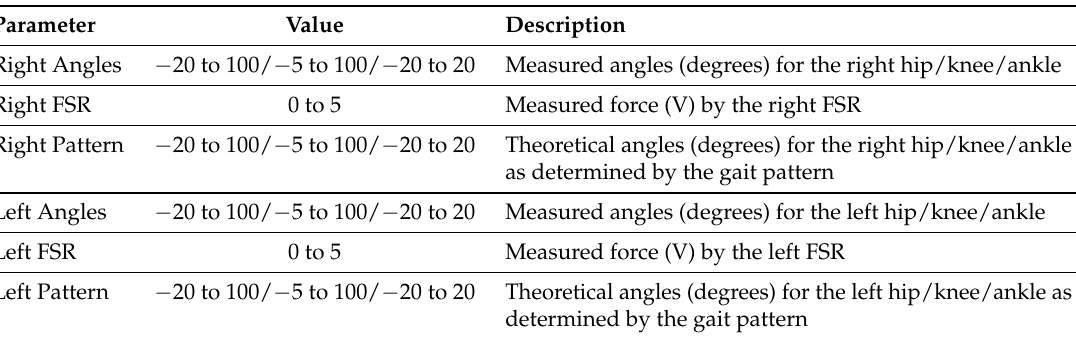
Table 9. H1 to PC data frame